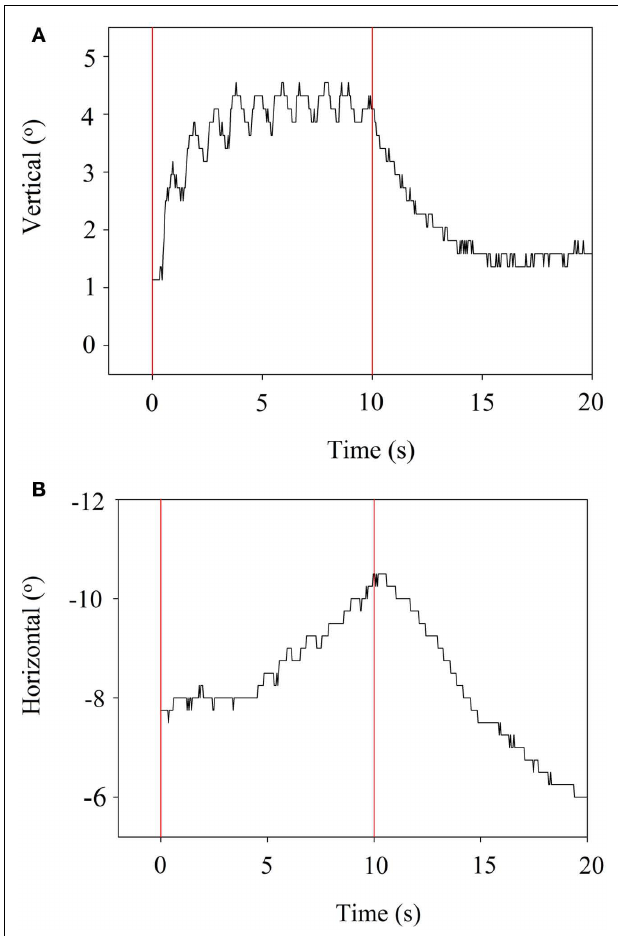
FIGURE 5 | (A) VOR vertical component during suprathreshold stimulation of the SAN.Vertical bars indicate the start and end of stimulation. (B) VOR horizontal component during suprathreshold stimulation of the SAN.Vertical bars indicate the start and end of stimulation.